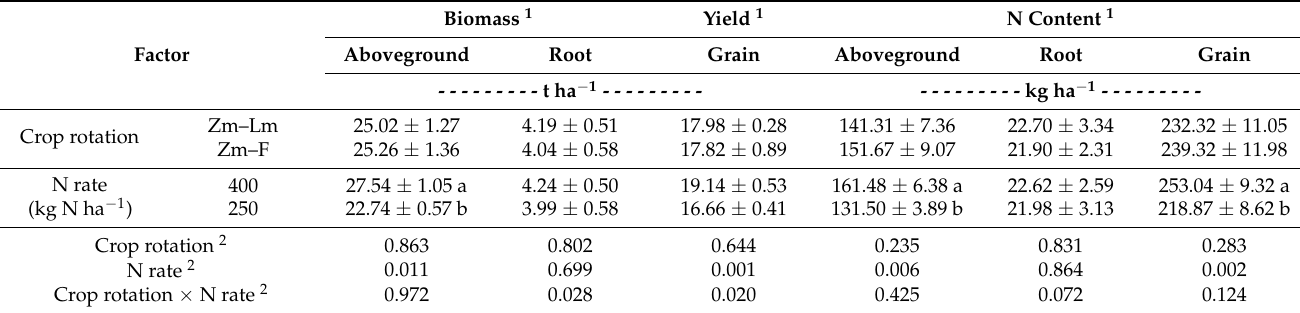
1 Average values of each variable ± standard error. Different letters in the column indicate statistically significant differences between the levels of each factor, based on multiple LSD Fisher comparisons ( α ≤ 0.05). 2 p value (<0.05) corresponds to the effect of the crop rotation and N dose factors and the interaction of the factors.